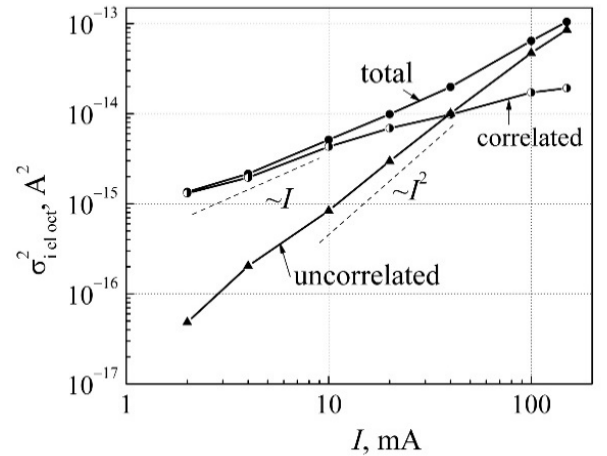
Figure 8. Dependence of the current fluctuation variance (total, correlated, and uncorrelated parts of the low-frequency electrical noise) on forward current in the one − octave frequency band with the central frequency of 240 Hz.